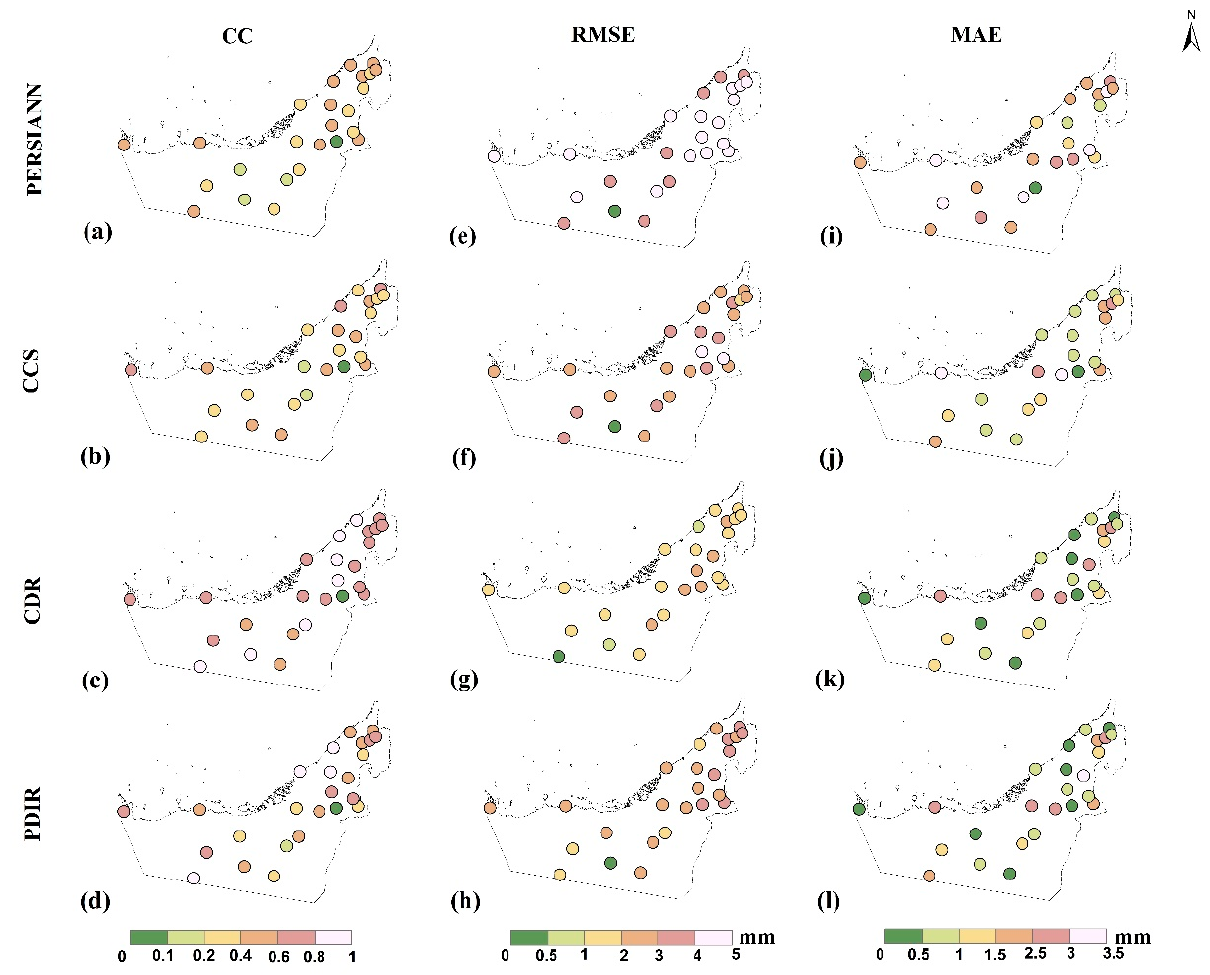
Figure 6. Stations-based performance of the products based on CC, RMSE, and MAE. Plots ( a – d ), ( e – h ), and ( i – l ) represent CC, RMSE, and MAE respectively for the gauge and satellite products.